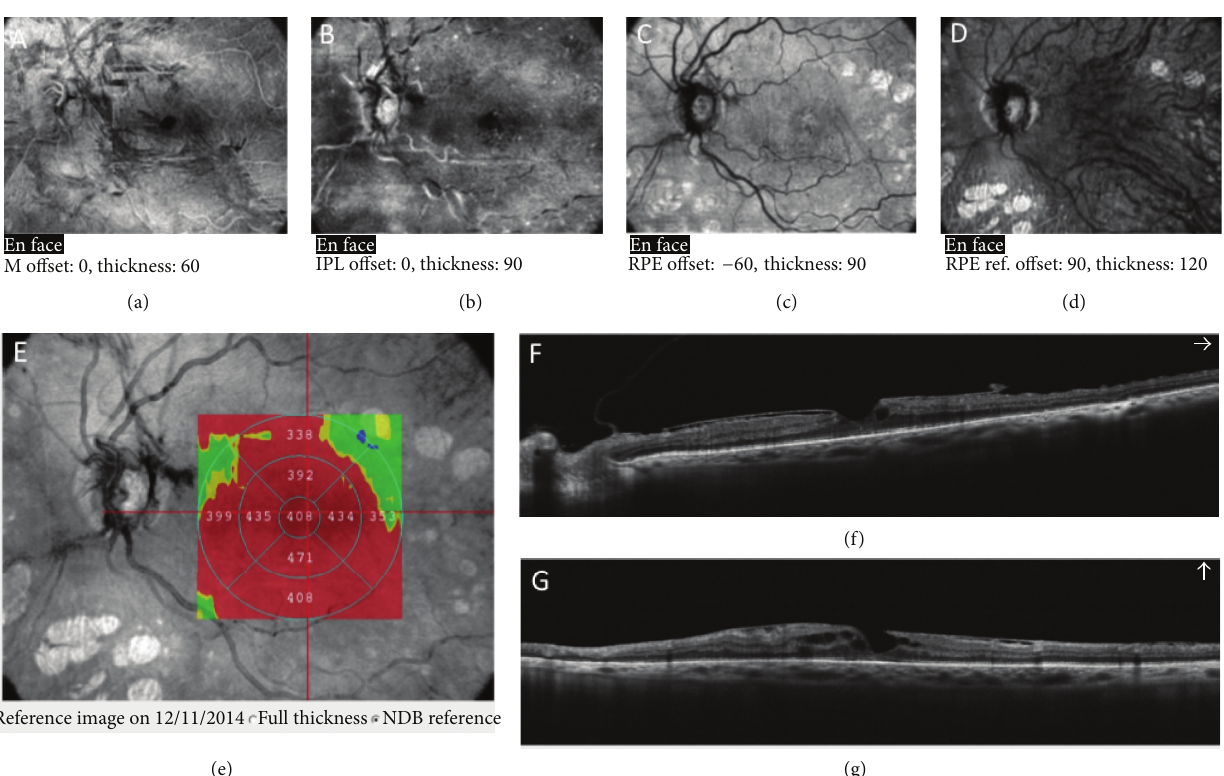
Figure 3: OCT images of diabetic eye. (a)–(d) En face OCT images at different segmentation thicknesses. (e) Increased retinal thickness map. (f)-(g) Vitreoschisis associated with vitreopapillary adhesion. The tangential traction induces wrinkling of ILM and intraretinal